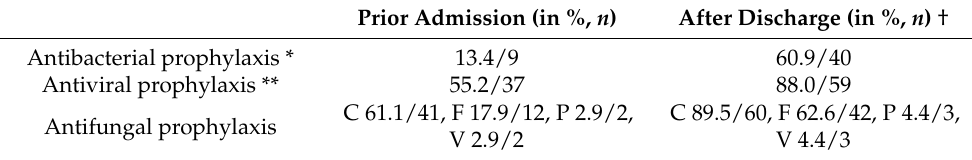
Table 4. Anti-infective prophylaxis before and after hospitalization. Prior Admission (in %, n ) After Discharge (in %, n ) † Antibacterial prophylaxis